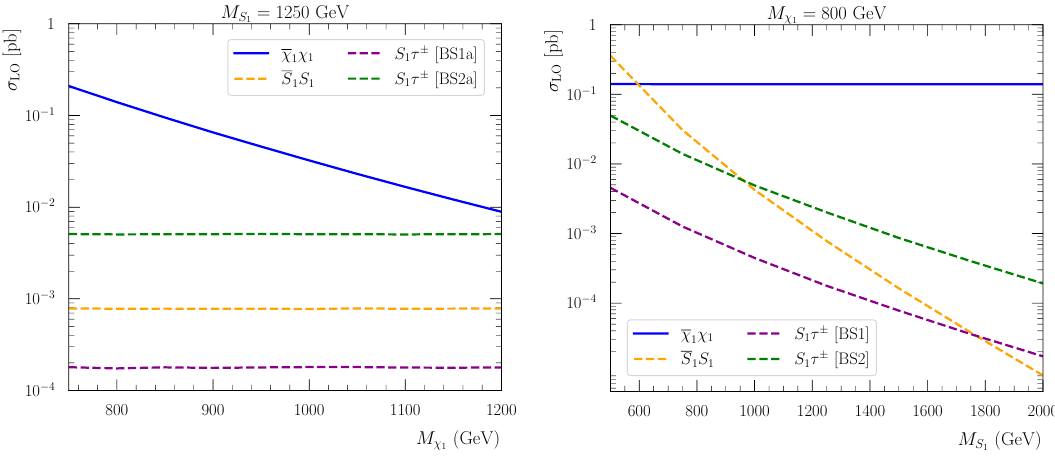
Figure 3 . Cross sections σ LO for S 1 and χ 1 production at the LHC as a function of M χ panel) and M S (right panel). We consider the production of a pair of χ 1 states (solid blue, LO), 1 of a pair of S 1 states (dashed orange, LO) and the associated production of S 1 with a tau lepton (LO). The latter cross section is shown for the benchmark points BS1a (dashed purple) and BS2a (dashed green). In the right panel we keep e λ L = λ L TeV /M S corresponding BS1 and BS2